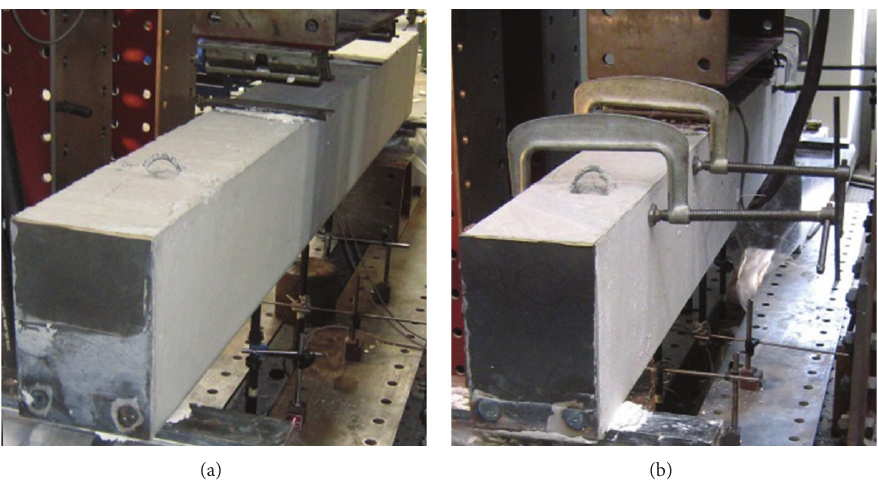
Figure 3: The test set-up for the reference beam (a) and the composite beam (b).